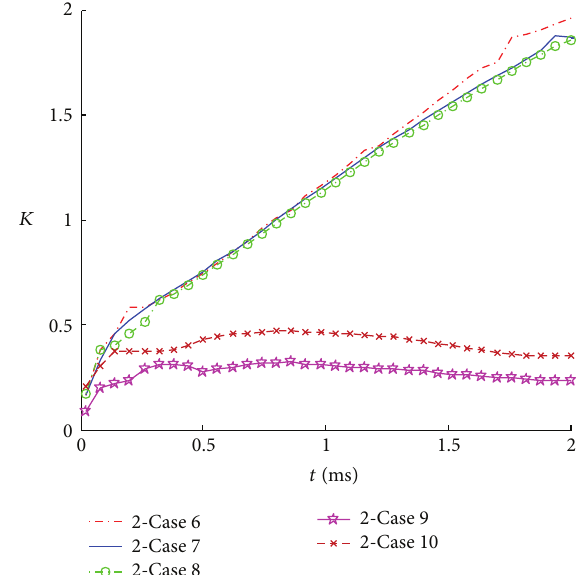
Figure 19: The crevasse variation of outer shell with full interlayer water; cases are shown in Table 10.